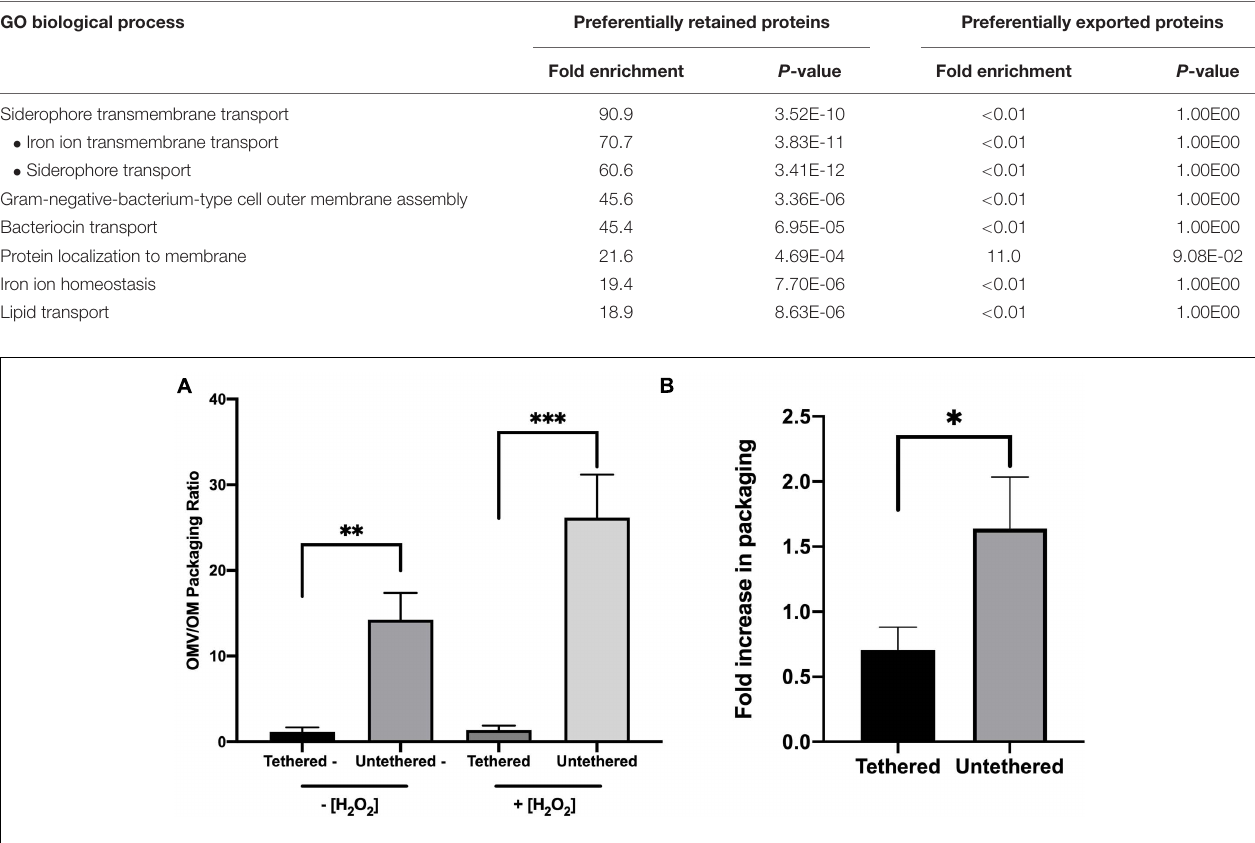
FIGURE 5 | Selective packaging of truncated OmpA compared to full-length OmpA into OMVs is exacerbated with oxidative stress. Packaging ratios (OMV:OM) for full-length OmpA and truncated OmpA were determined by immunoblotting for untreated BL21/pGI10 and BL21/pGV30 cultures, respectively, for unstressed cultures and stressed cultures (A) . (B) OMV:OM packaging ratios for the full-length and truncated OmpA constructs in unstressed cultures from part A was compared to that for 3 h H 2 O 2 -treated cultures and fold-change calculated ( n = 6 for pGI10, n = 5 for pGV30). Error bars are SEM. P -values according to